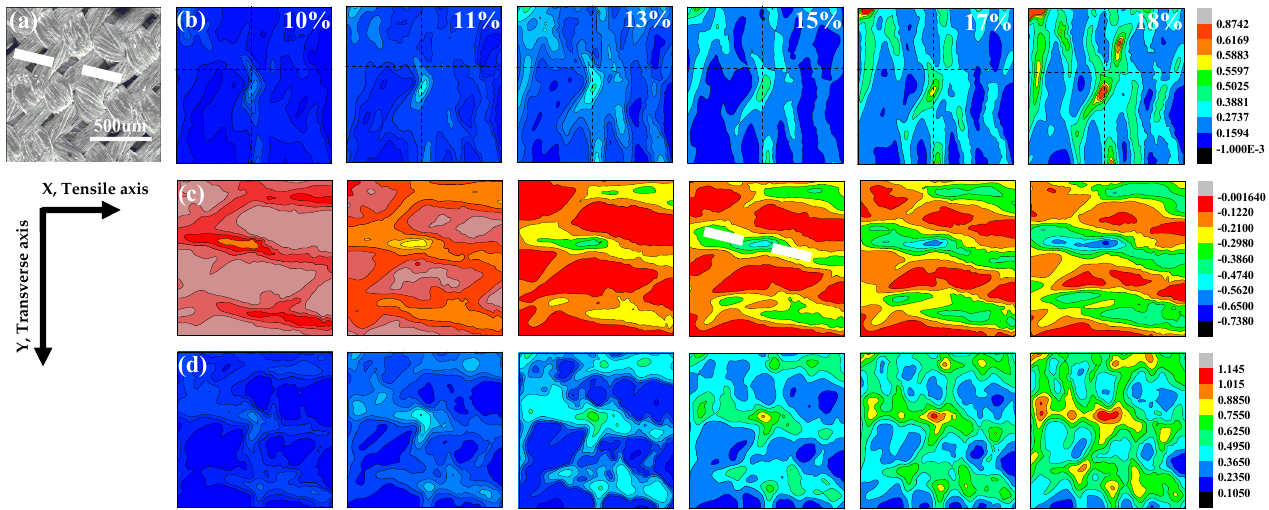
Figure 6. DIC images of strained 45 ◦ specimen. ( a ) Speckle image of the 45 ◦ specimen before loading. ( b ) Contour maps of the ε xmax field. ( c ) Contour maps of the ε ymax field. ( d ) Contour maps of the γ max field.